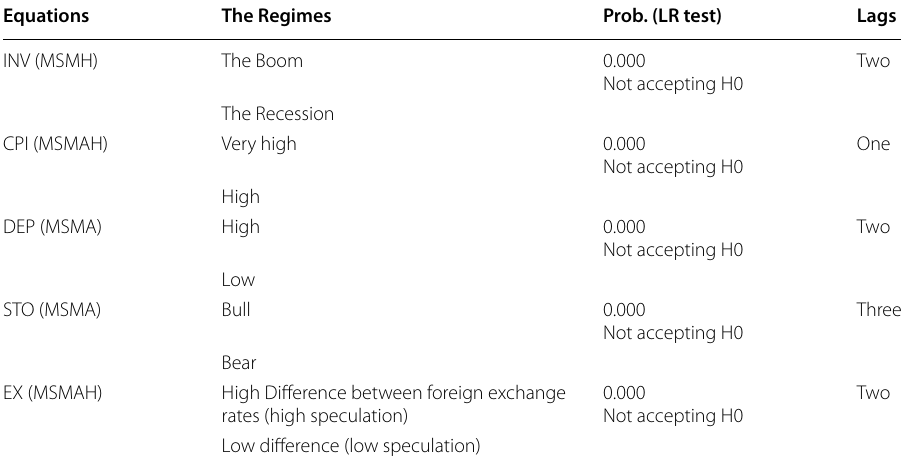
Table 2 The number of regimes and lags and LR test